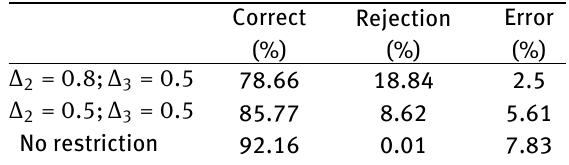
Table 3: Results of ANFIS for subjectivity dataset